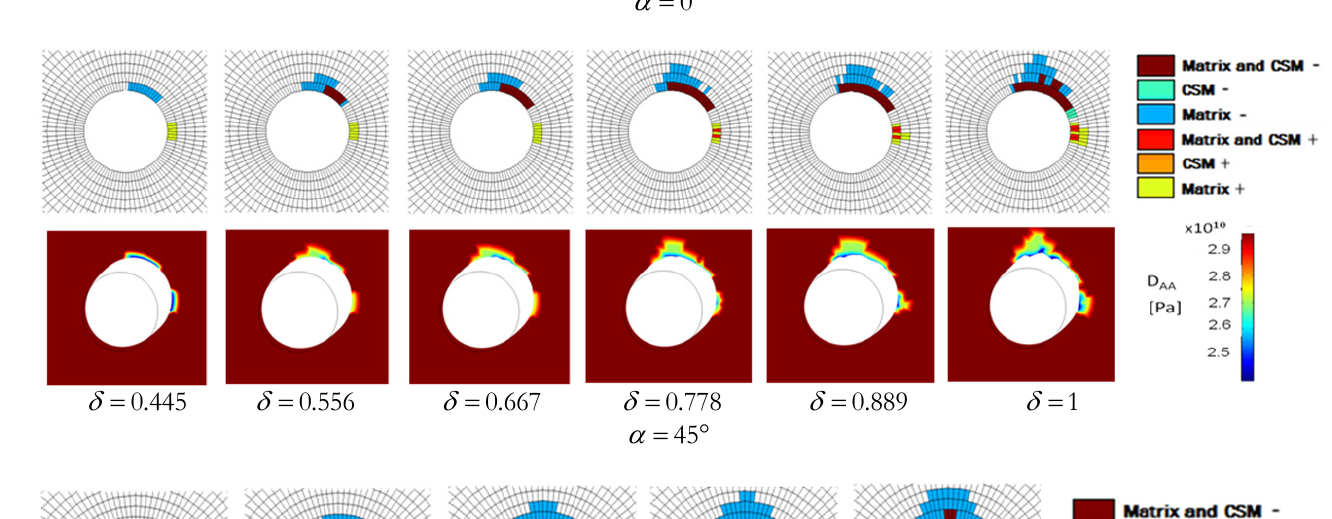
Figure 5: Progressive damage in the composite laminated plate for 0   , 45 ,  90  and for different values of / where u is current pin displacement and equivalent material stiffness of the laminate along the fiber